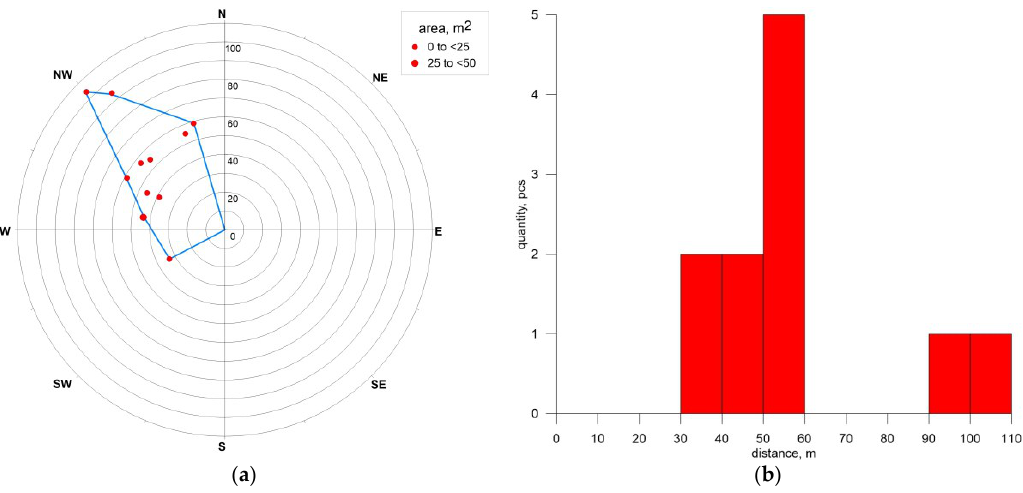
Figure 15. Distribution of impact hollows around AntGEC: ( a ) position of impact hollows around AMP; the diameter of the red circle is proportional to the area of the hollow; the line connecting the farthest points outlines the impactor scattering zone—zone A; ( b ) distribution of the number of impact hollows in relation to the distance from the AMP.